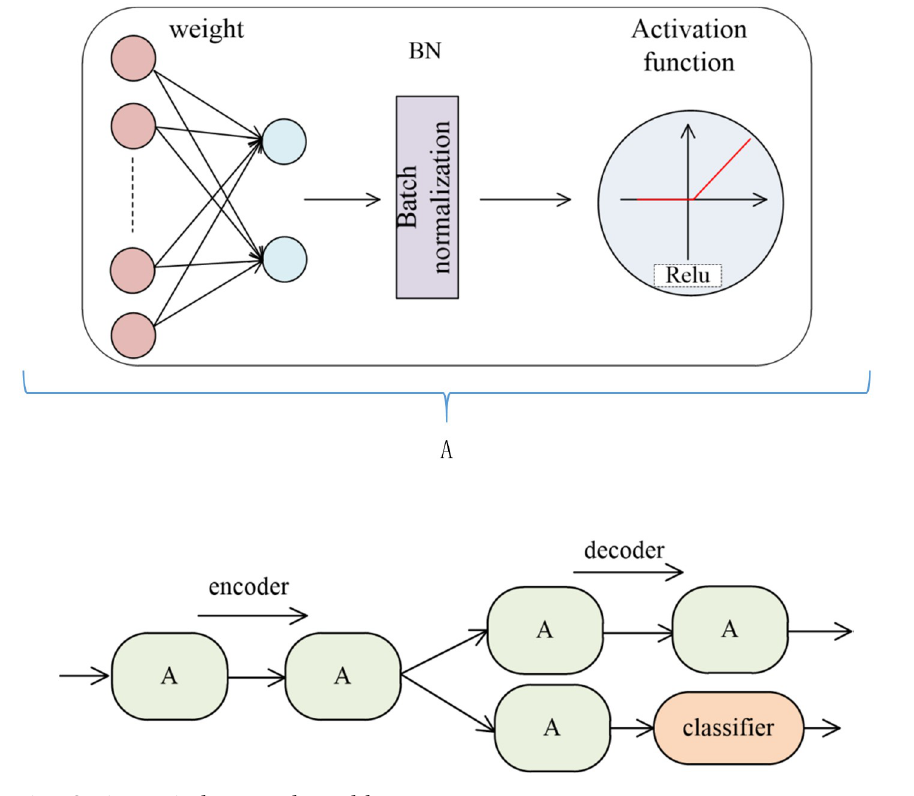
Fig 1. Semi-supervised autoencoder